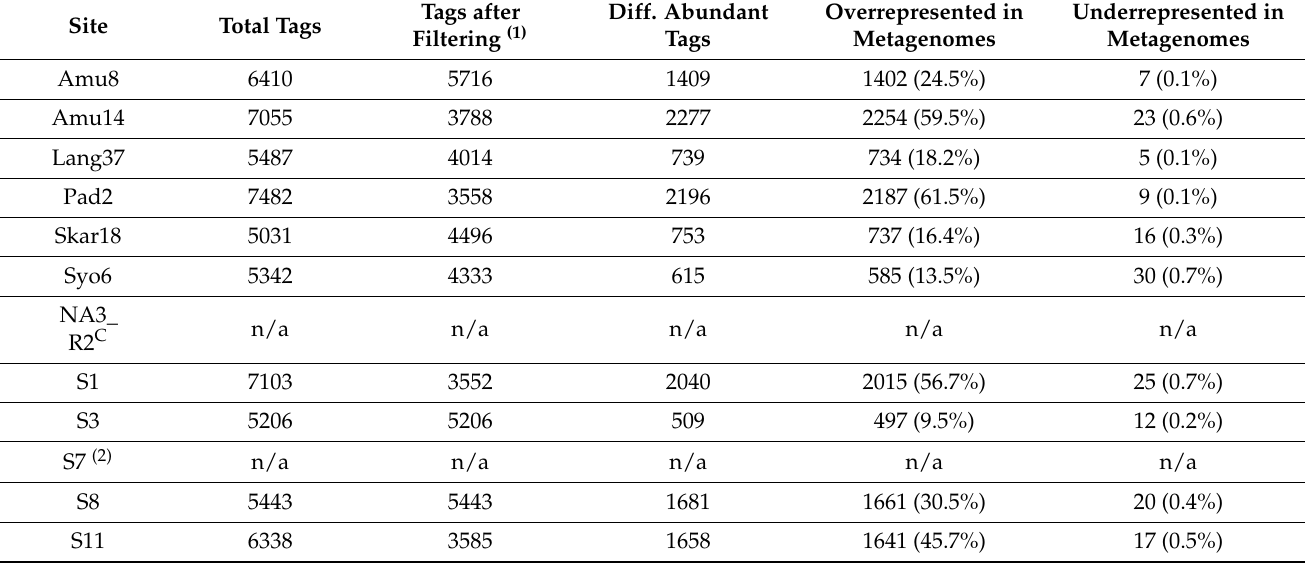
Table 1. Differential abundance of taxonomic tags (species taxonomic level) in metagenomic and metabarcoding studies of terrestrial soil samples from polar regions. Sequences were classified with the Kraken 2 software and differential abundance analyses performed using edgeR and standard settings. The percentage of filtered taxonomic tags over- or underrepresented in metagenomes is given in brackets.